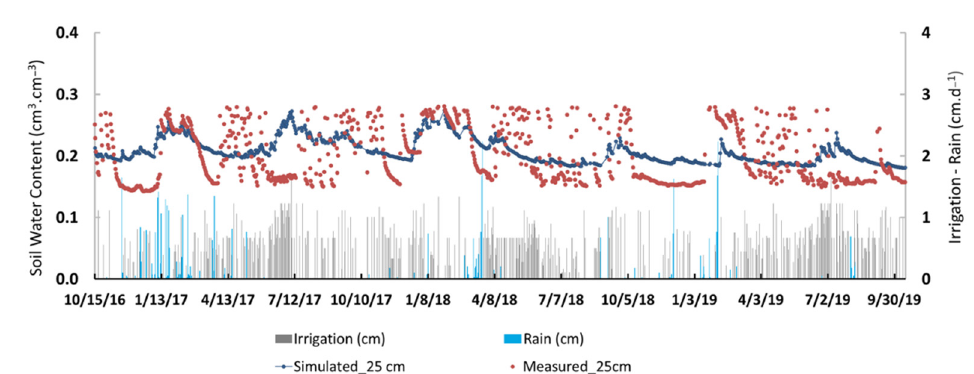
Figure 7. Effects of irrigation and rain on the measured and HYDRUS-1D simulated soil water contents at a depth of 25 cm at the PSH site.